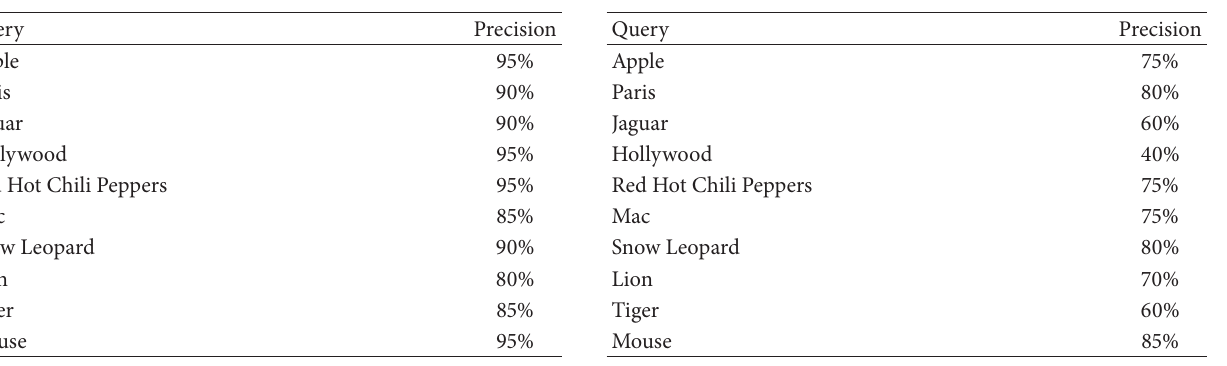
Table 1: The first experiment values. Table 2: The second experiment